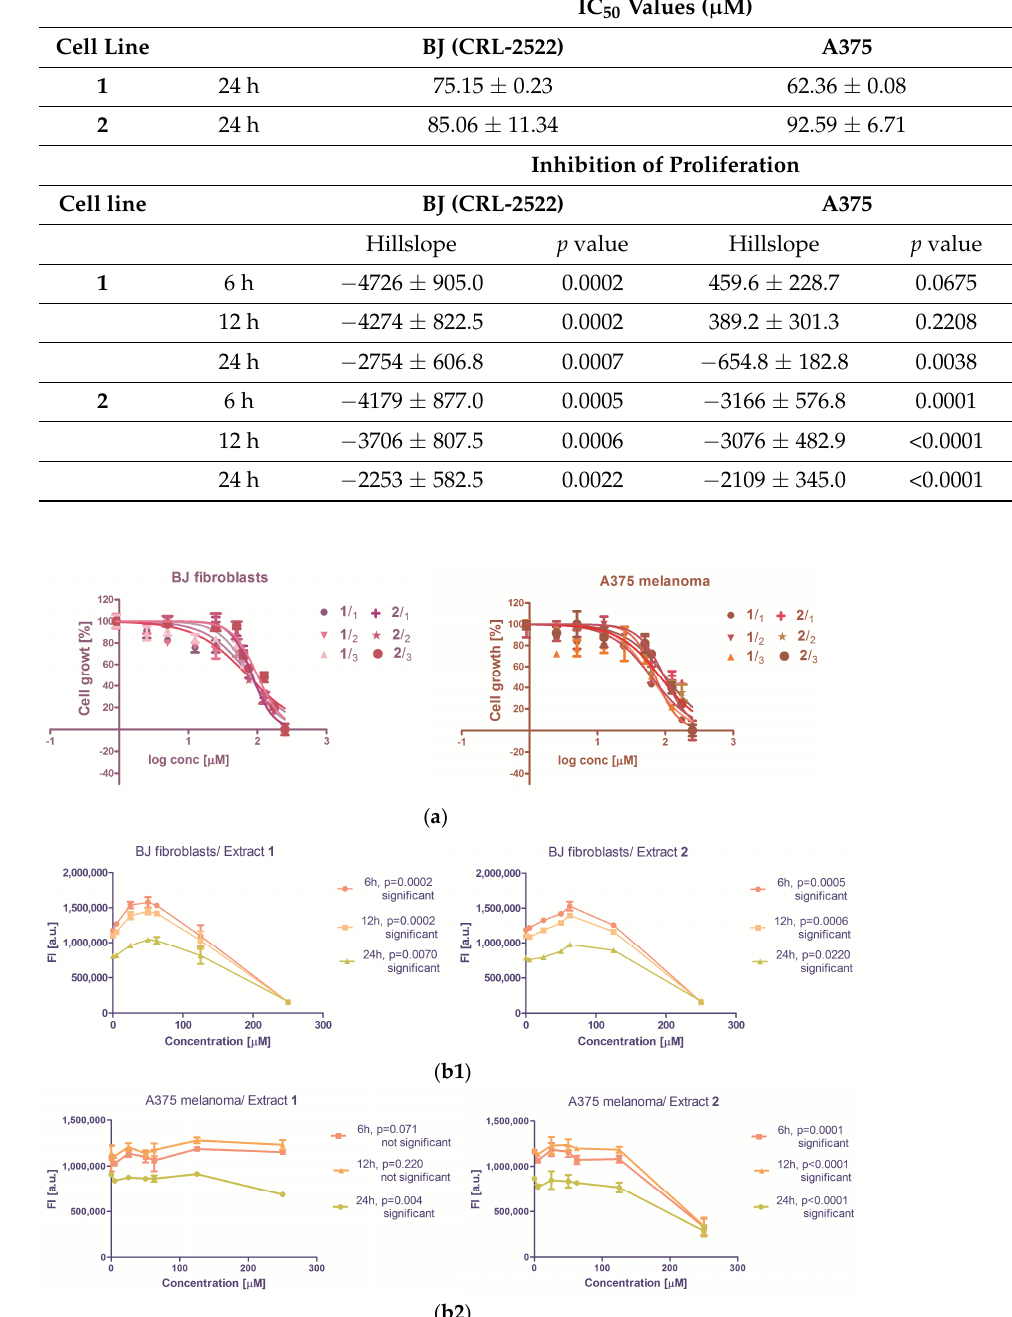
Table 2. The cytotoxicity of zeaxanthin-rich extracts 1 and 2, expressed as half inhibitory concen- tration (IC 50 , sigmoidal dose-response) and the antiproliferative capacity expressed as significant negative hillslope derived from the linear regression of time-dependent inhibition.